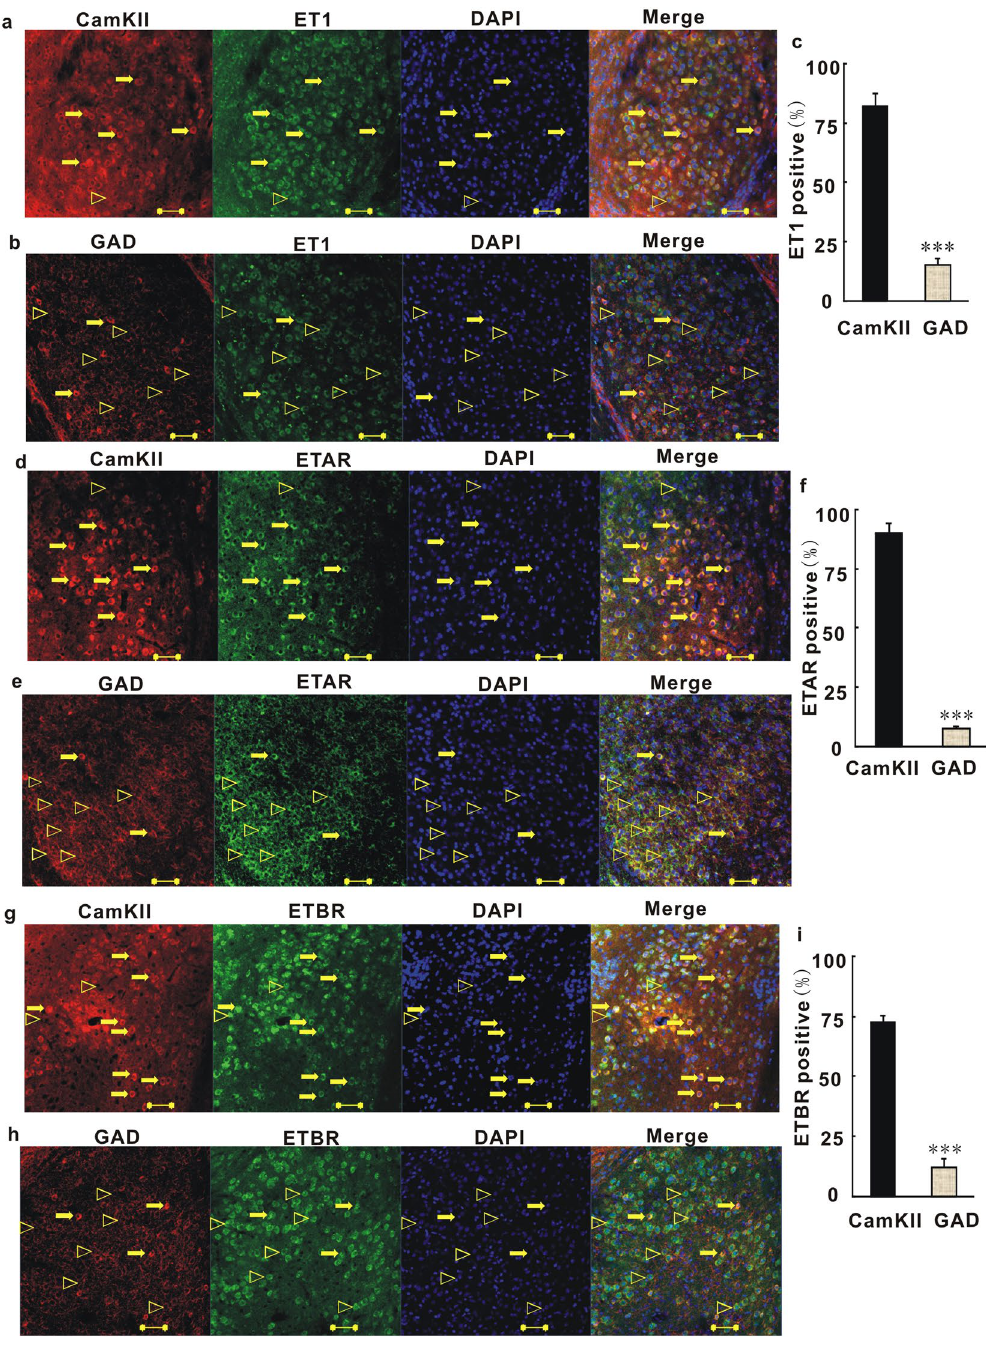
Figure 3. ET1 and its receptors (ETARs and ETBRs) are mainly present at glutamatergic neurons in the BLA. ( a ) Coronal sections of the BLA of C57 mice were stained with anti-CamKII antibody, anti-ET1 antibody and DAPI (blue). Most the right image shows combinations of red (CamKII), green (ET1) and blue (DAPI) channels. Unfilled triangles, ET1-positive neurons without CamKII; arrows, ET1- and CamKII-positive neurons. ( b ) Coronal sections of the BLA were stained with anti-GAD antibody, anti-ET1 antibody and DAPI. Most the right image shows combinations of red (GAD), green (ET1) and blue (DAPI) channels. Unfilled triangles, ET1-positive neurons without GAD; arrows, ET1- and GAD-positive neurons.( c ) Quantitative analysis of pyramidal neurons and GABAergic neurons that are positive for ET1. ( d ) Coronal sections of the BLA were stained with anti-CamKII antibody, anti-ETAR antibody and DAPI. Most the right image shows combinations of red (CamKII), green (ETAR) and blue (DAPI) channels. Unfilled triangles, ETAR-positive neurons without CamKII; arrows, ETAR- and CamKII-positive neurons. ( e ) Coronal sections of the BLA were stained with anti-GAD antibody, anti-ETAR antibody and DAPI. Most the right image shows combinations of red (GAD), green (ET1) and blue (DAPI) channels. ( f ) Quantitative analysis of pyramidal neurons and GABAergic neurons that were positive for ETAR. Unfilled triangles, ETAR-positive neurons without GAD; arrows, ETAR- and GAD-positive neurons. ( g ) Coronal sections of the BLA were stained with